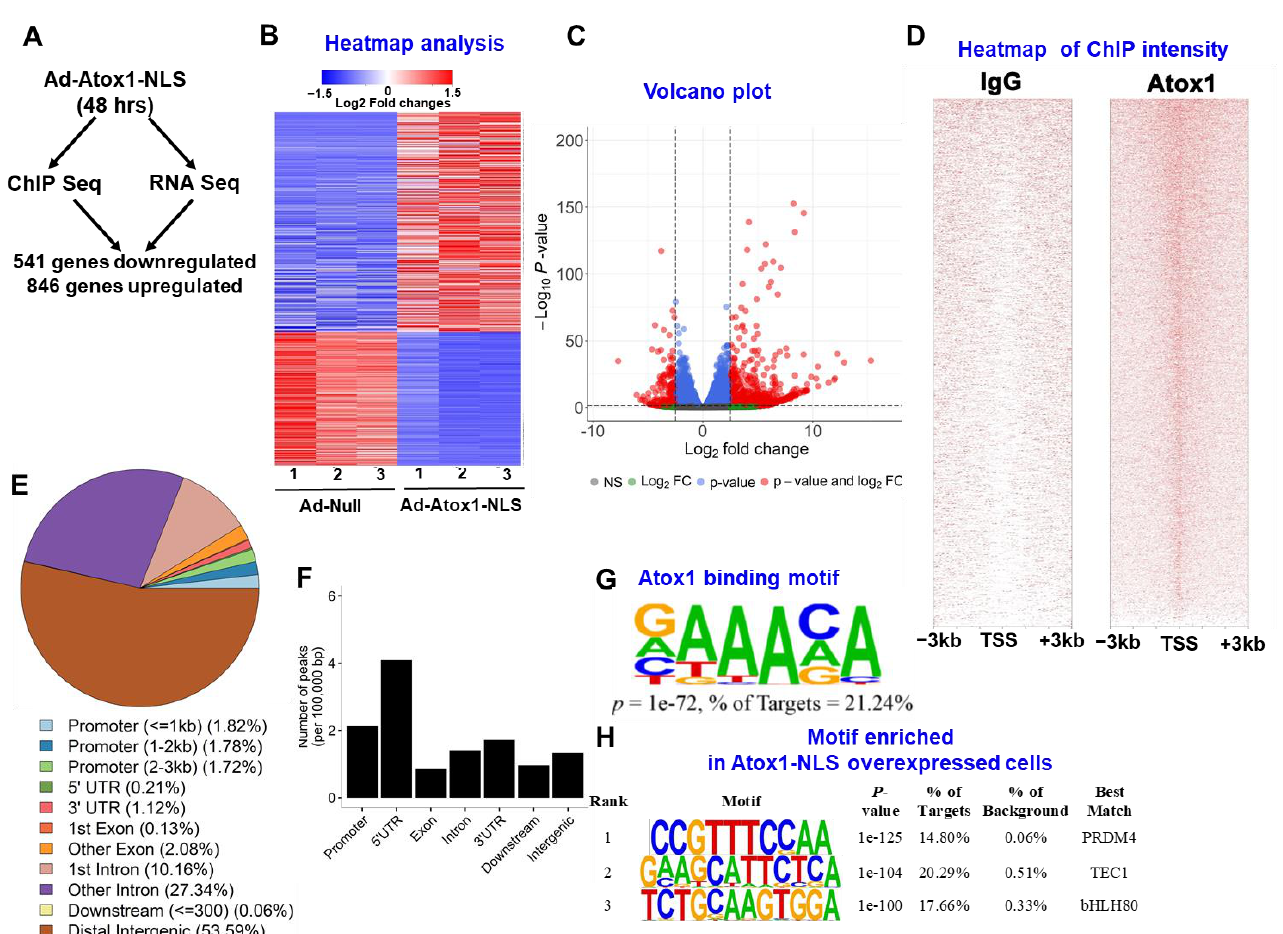
Figure 3. Genome-wide Atox1 gene targets identified by combining RNA-Seq and ChIP-Seq analysis. ( A ). Strategy for identifying Atox1 gene targets in HUVEC cells transfected with Ad-Atox1-NLS for 48 h. Atox1 gene targets represent genes that were bound by Atox1 and showed differential expression in response to Atox1-NLS. ( B ). Heat map of expression pattern for differentially expressed genes (DEGs) identified by combining ChIP-Seq and RNA-Seq. ( C ). Volcano plot of the pattern for all genes analyzed in RNA-Seq. Red dots represent DEGs with adjusted p < 0.05 and fold change >2.5 or <0.4. ( D ). Heatmap showing signal intensity of Atox1 peaks in ChIP-Seq in a 3 kb window centered around transcription start sites (TSSs) of genes across the genome. Atox1 was specifically precipitated from fragmented DNA-protein complexes by Monoclonal Anti-Atox1 antibody but not nonimmune IgG. Samples were used for ChIP-Seq. ( E ). Pie chart showing genomic distribution of Atox1-binding peaks. The genomic features (promoters, 5 (cid:48) UTRs, exons, introns, 3 (cid:48) UTRs, down- stream, and intergenic regions) were defined based on RefSeq gene annotations. ( F ). Bar graph showing the distribution of Atox1-binding peaks in each genomic feature after normalization to the size of each category in 100 kb. ( G ). Atox1 binding motif (GAAAGA) in Atox1 ChIP-Seq peaks that correspond to the one identified in our previous work [25]. ( H ). Top 3 enriched motifs in Atox1 ChIP-Seq